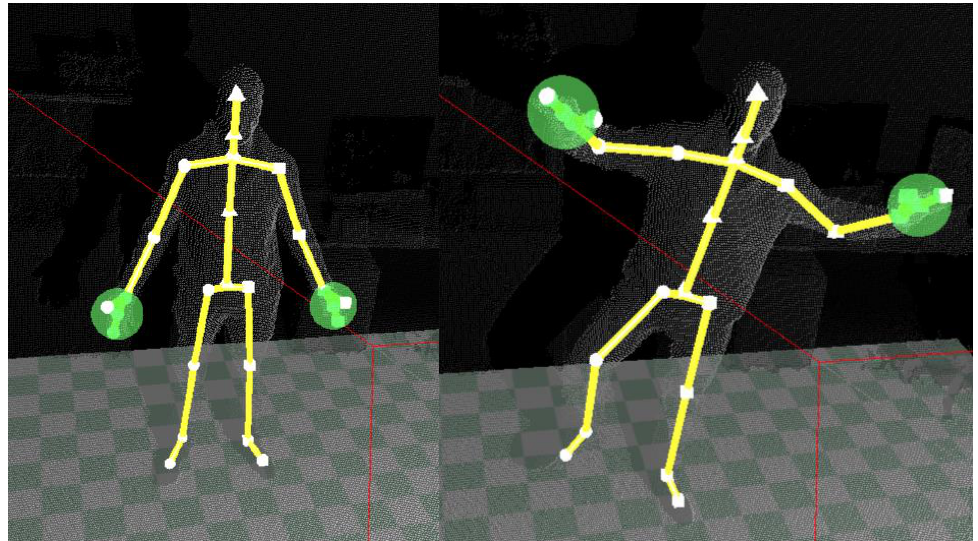
Figure 3. An example of body motion tracking through the built-in skeletal model.